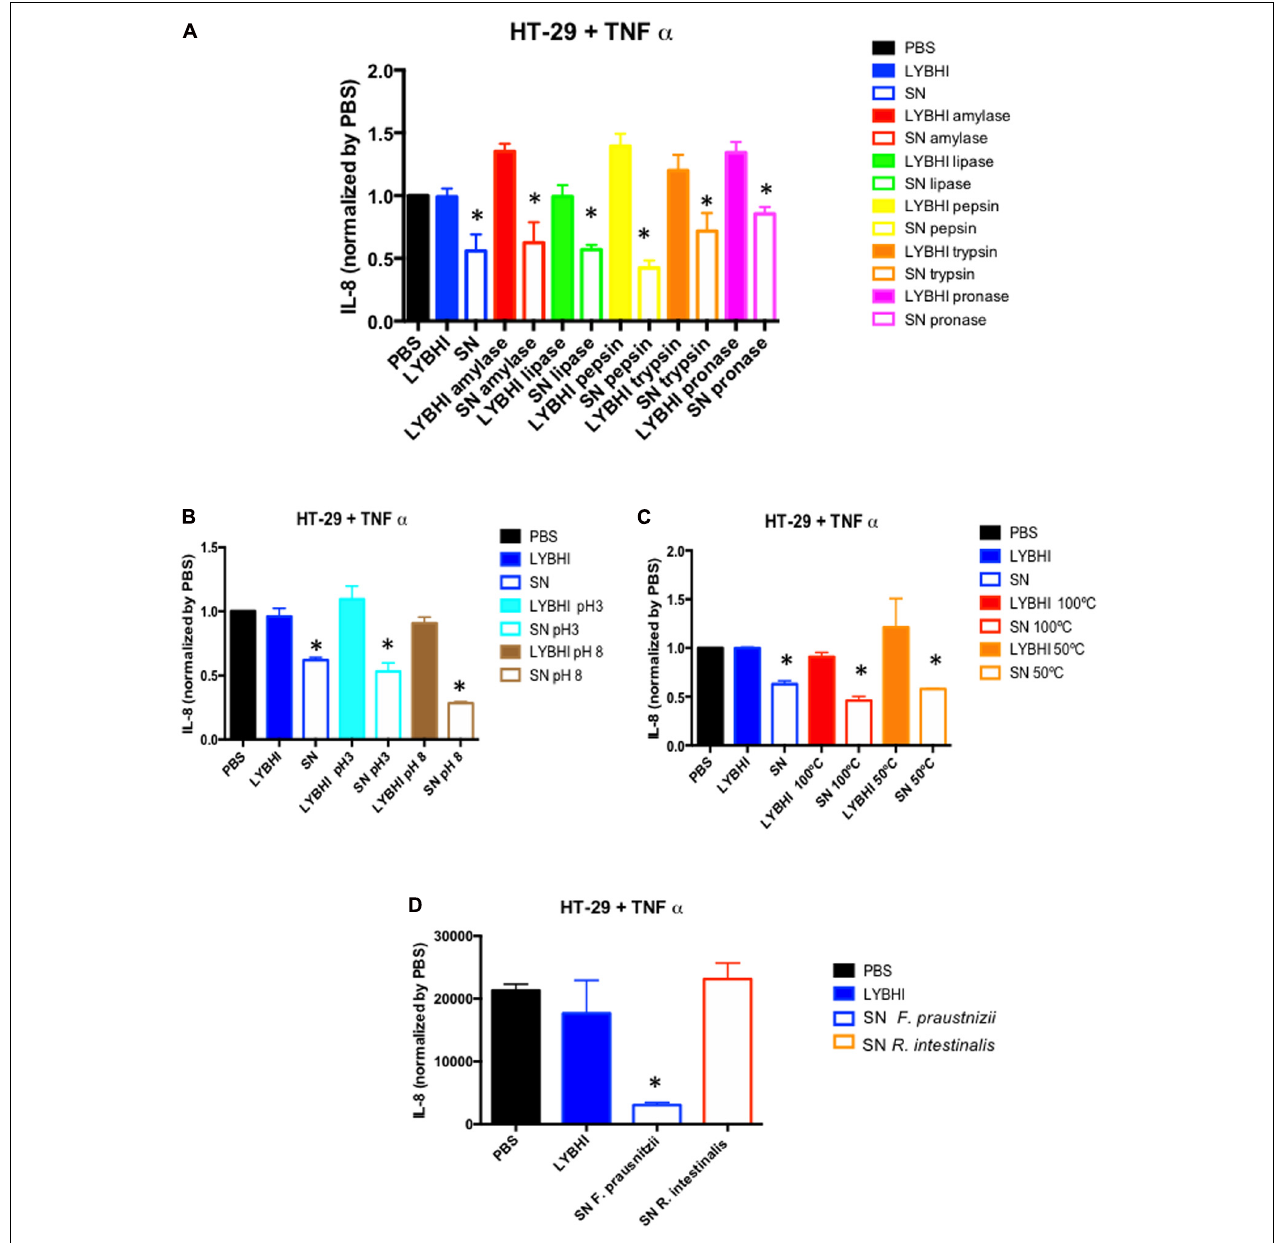
FIGURE 1 | In vitro immune-modulatory test on HT-29 cells stimulated with TNF- α . Anti-inflammatory activity of Faecalibacterium prausnitzii A2-165 supernatant (SN) and culture medium (LYBHI) submitted to different treatments: (A) enzymatic treatments: amylase (red), lipase (green) pepsin (yellow), trypsin (orange) and pronase (pink), (B) pH modifications: pH 3 (cyan) and pH 8 (brown), and (C) different temperatures: 100 ◦ C (red) and 50 ◦ C (orange). (D) Comparison of Roseburia intestinalis DSM14610T SN and F. prausnitzii A2-165 SN effect. Bacterial SNs were recovered, filtered and submitted to different treatments (if indicated) before being tested in co-incubation assays with HT-29 cells challenged with TNF- α . IL-8 concentration was determined by ELISA and used as a read-out of the inflammatory status of the cells. The results were normalized by the negative control (PBS) (for material and methods details see Supplementary Data 1). ∗ p < 0.05 versus LYBHI (bacterial culture medium) ( n = 3 ∗